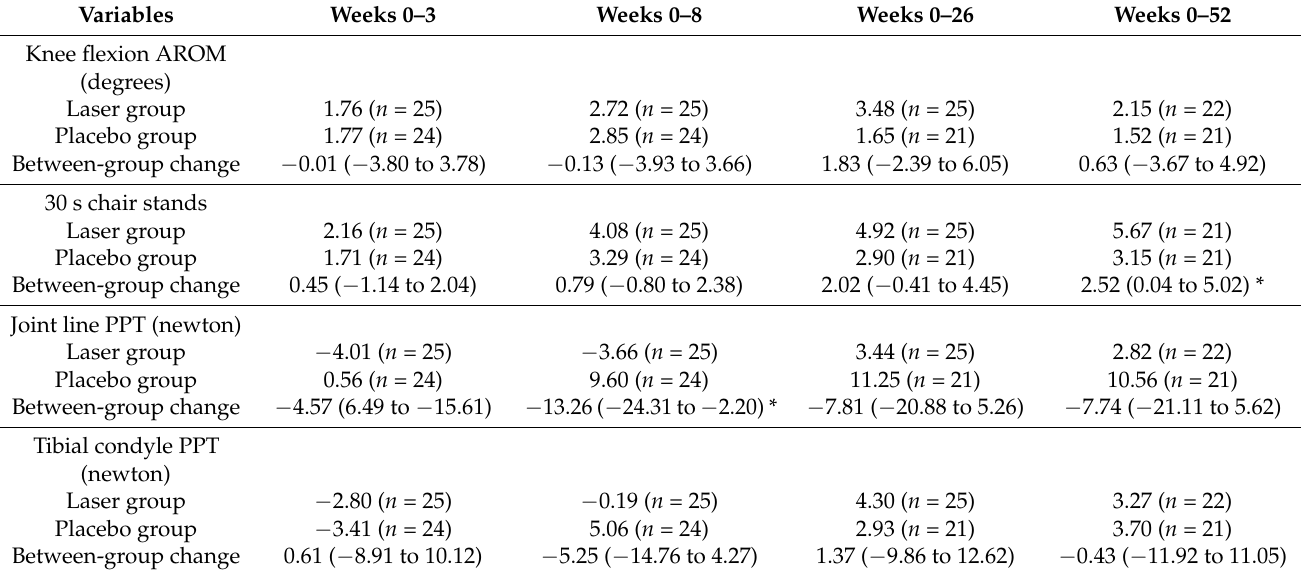
Table 3. Physical assessments: within- and between-group changes from baseline (higher score is